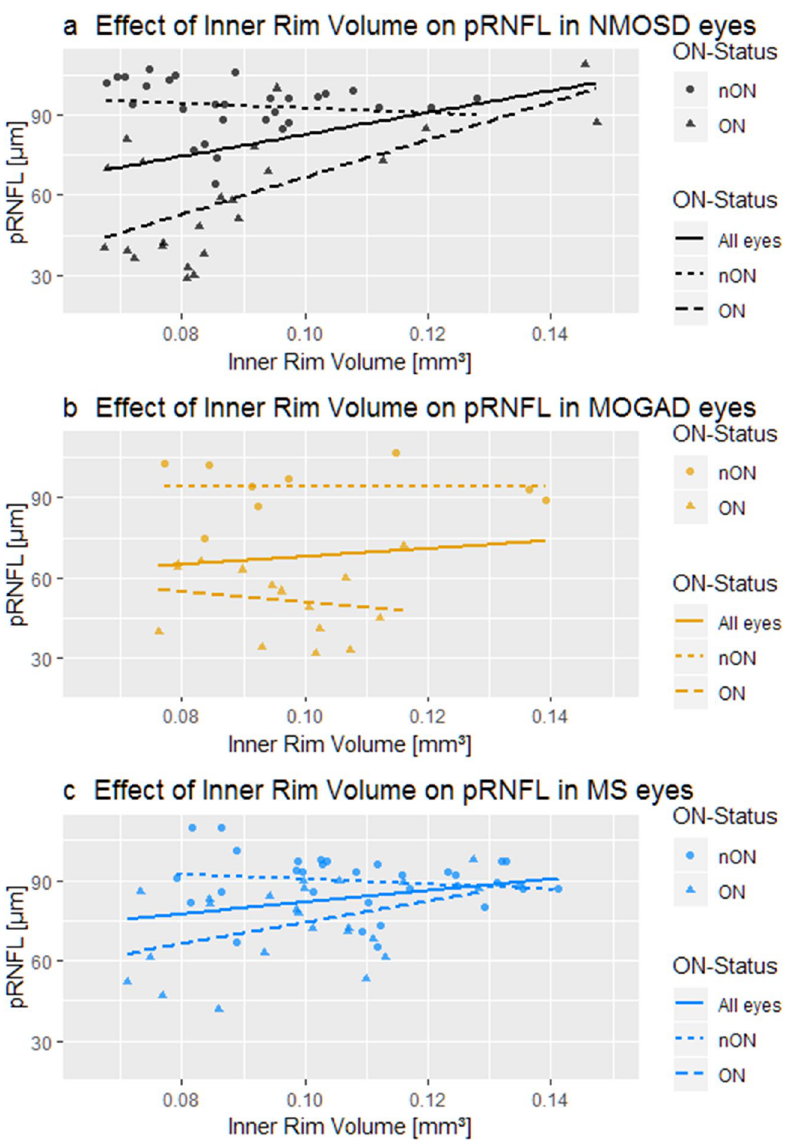
Figure 4. Association between inner rim volume and pRNFL in ( a ) NMOSD (Beta = 724.92 ± 208.93; p = 0.001), ( b ) MOGAD (Beta = 653.78 ± 329.25; p = 0.06) and ( c ) MS eyes (Beta = 315.02 ± 130.76; p = 0.02) AQP4-IgG: Aquaporin-4-IgG seropositive patients; MOG-IgG: Myelin-Oligodendrocyte-Glycoprotein-IgG seropositive patients; MS: Multiple Sclerosis